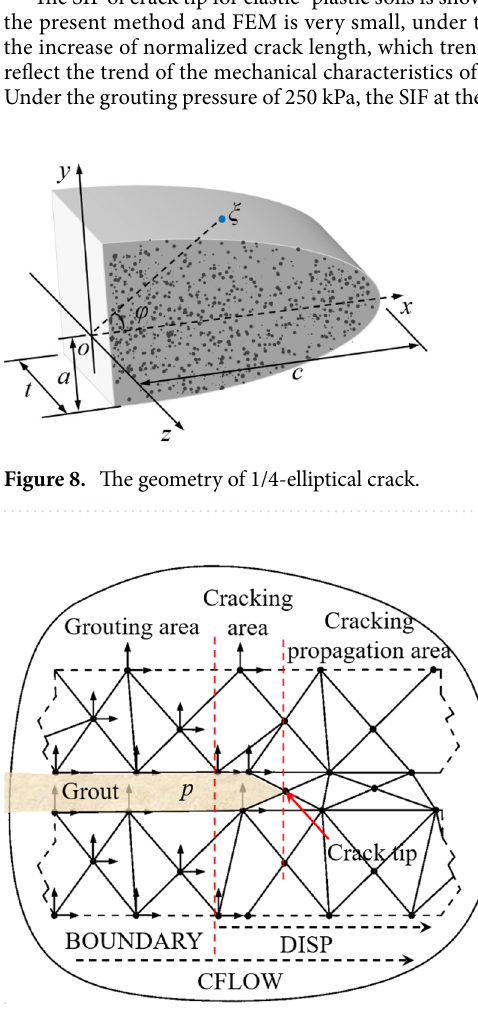
Figure 9. Schematic diagram of finite element analysis model of crack